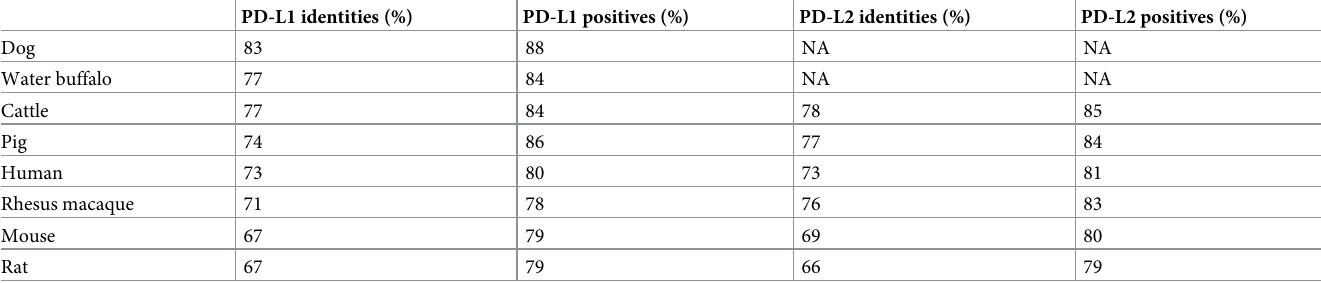
Percentages of identical and positive (allowing conservative substitution) matches in the amino acid sequence of feline PD-L1 and PD-L2 are calculated in relation to orthologs from other mammalian species by Protein BLAST (blastp). NA: not